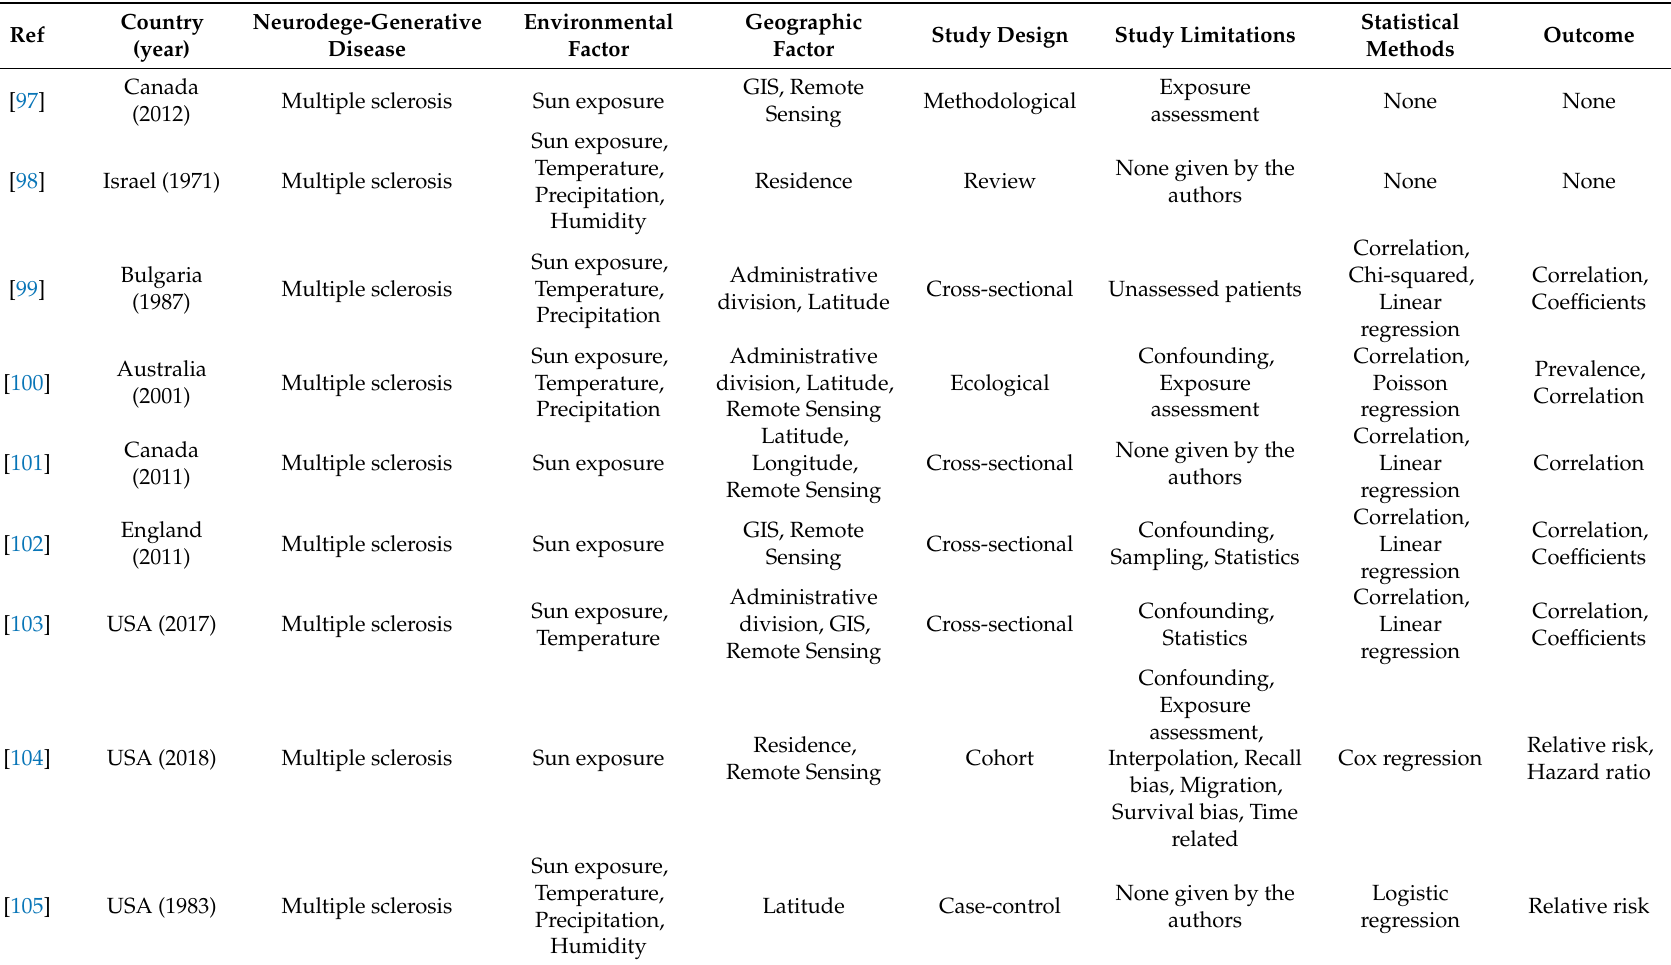
Table 3. Study characteristics of the 34 included papers